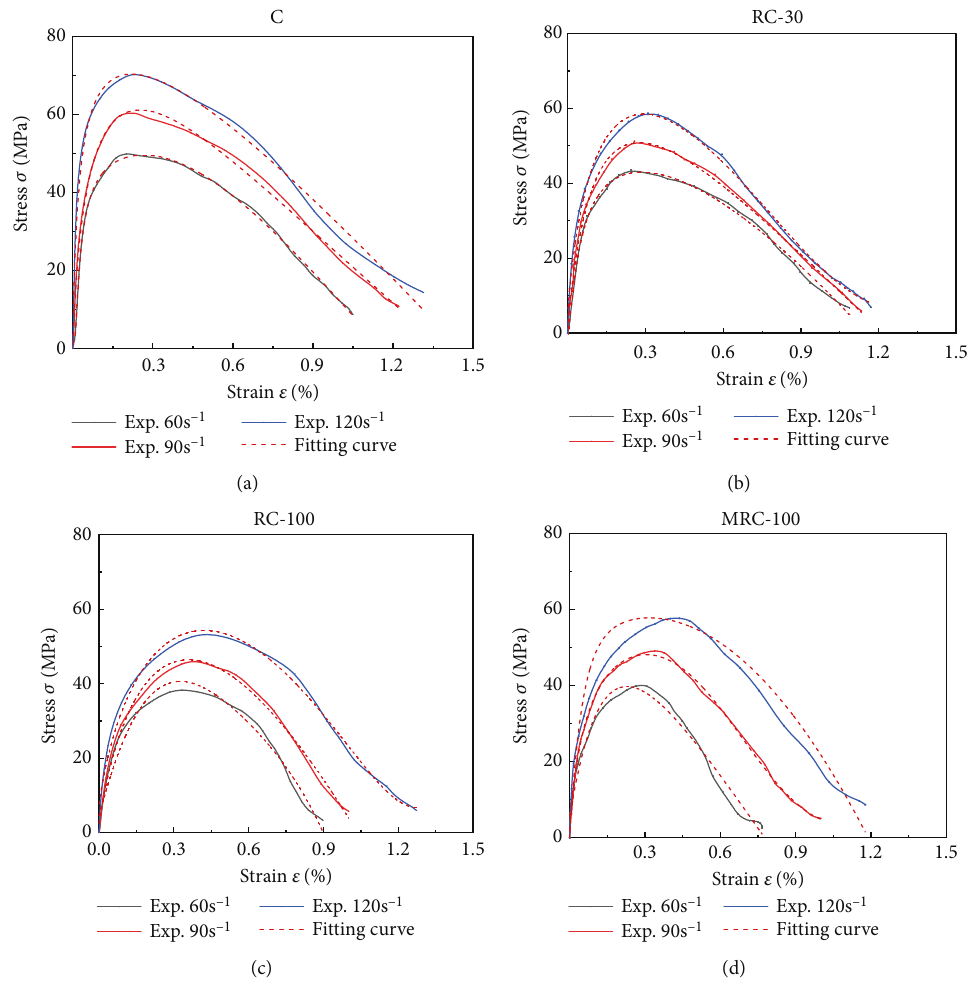
Figure 11: Validation of the constitutive equation: (a) C; (b) RC-30; (c) RC-100; and (d)